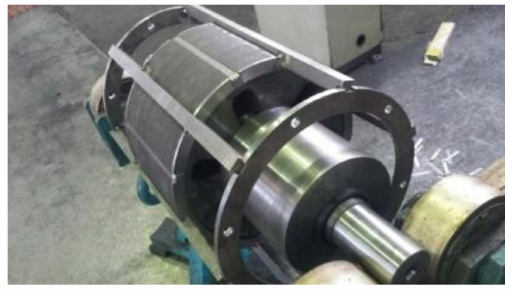
Figure 17. Photographs of the fabricated stator core with